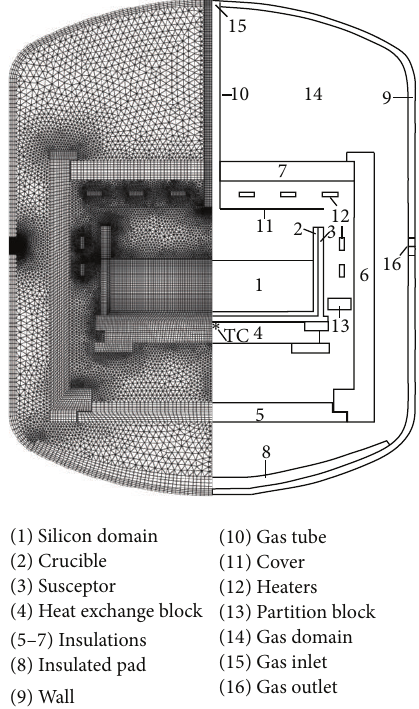
Figure 1: Configurations and computational grids of two industrial- size DS